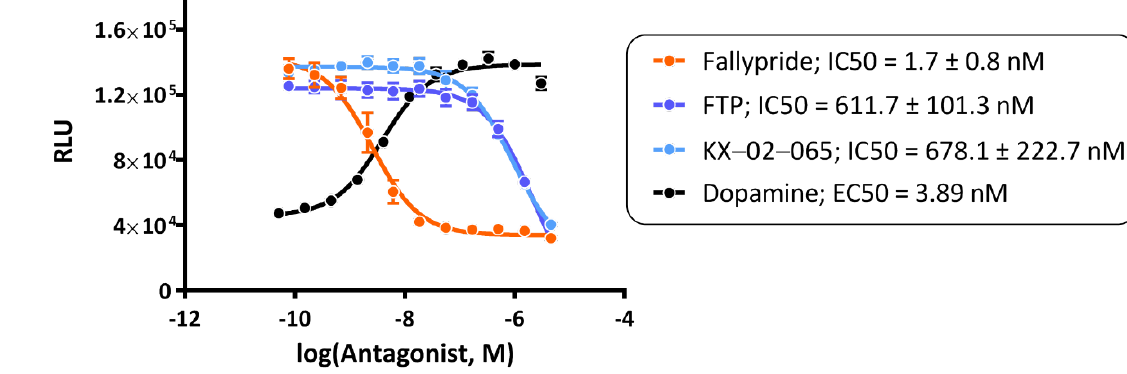
Figure 2. Fallypride, FTP, and KX-02-065 were investigated as antagonists for D 3 by β -arrestin recruitment assay. For antagonist mode, functional assays were performed in the presence of 30 nM dopamine. The graph represented a single experiment, and the IC50 value was represented of the mean ± sd of three to four individual experiments.